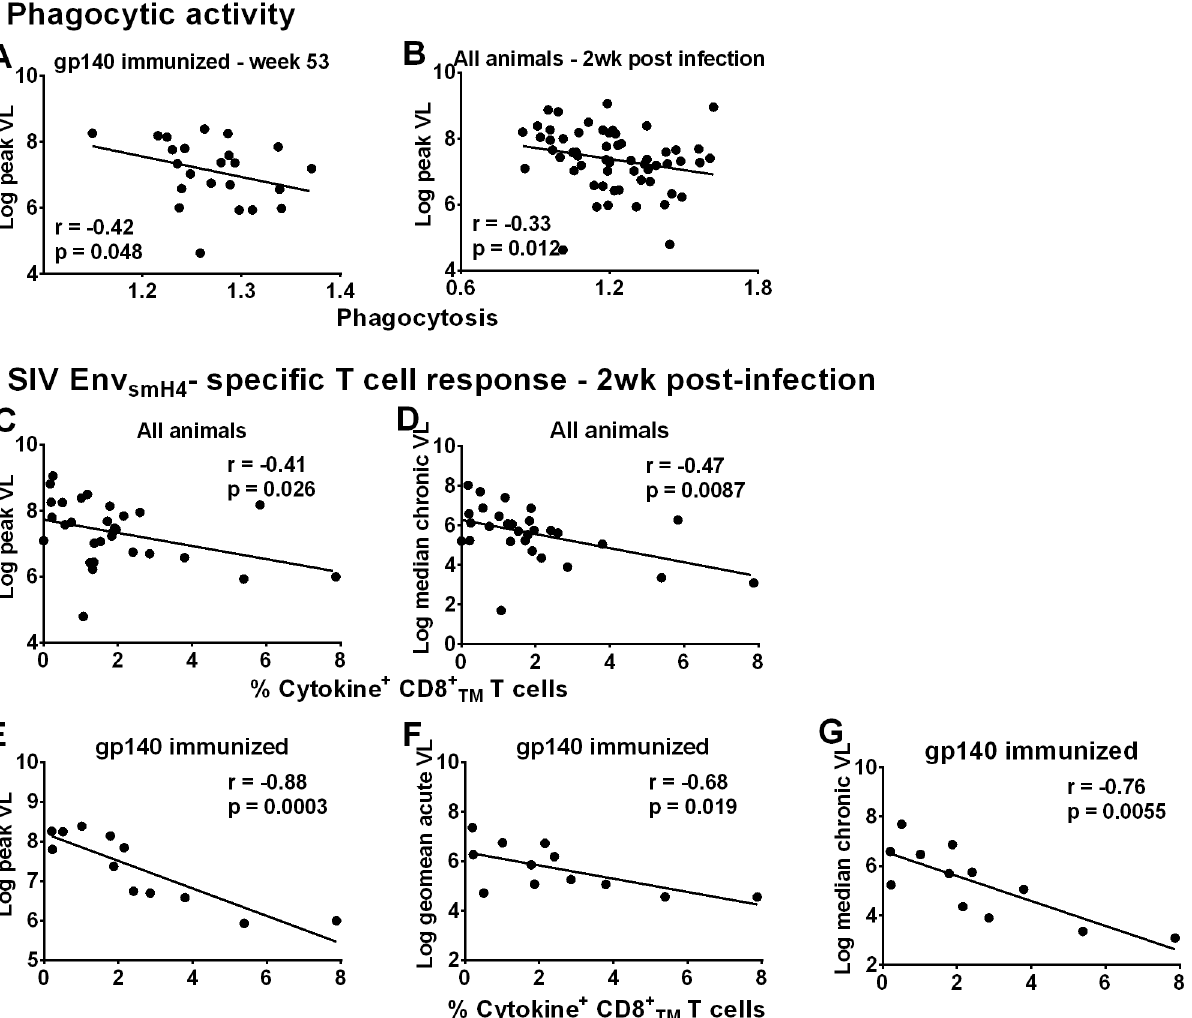
Fig 5. Immunological correlates of viremia control. Correlation of phagocytic activity (expressed as phagocytosis score/background phagocytosis) of gp140-immunized macaques using gp140 targets 2 weeks post-second Env boost (wk 53) with peak viral load (A). Correlation of phagocytic activity of all macaques 2wkpi with peak viral load (B). Correlation of peripheral Env smH4 -specific CD8 + TM T cells (% CD8 + TM T cells expressing IL-2, IFN- γ , and TNF- α ) in all animals with reduced peak viral load (C) and chronic viremia (median over weeks 8 – 24) (D). Correlation of Env smH4 -specific CD8 + TM T cells (% CD8 + TM T cells expressing IL-2, IFN- γ , and TNF- α ) 2wkpi in gp140-immunized macaques with (E) peak viral load, (F) acute viral load (geometric mean over weeks 1 – 6), and (G) chronic viremia (median over weeks 8 – 24). One gp140-immunized female macaque remained uninfected so is not included in these correlations with viral load. Due to the large number of macaques only half of the macaques in each group were assessed for CD8 + TM T cell SIV smH4 Env-